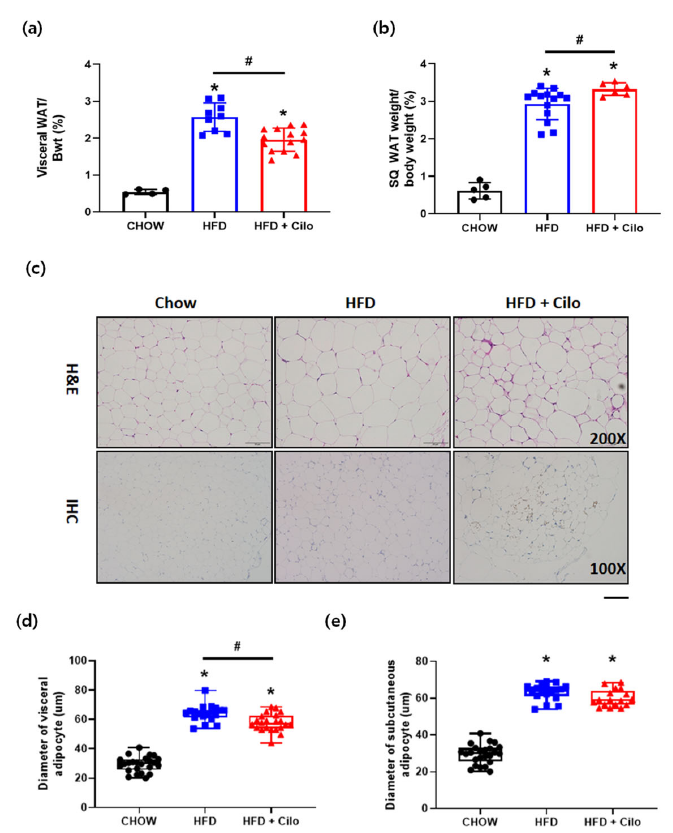
Figure 2. Cilostazol treatment modified WAT and reduced the size of adipocytes in visceral WAT. ( a ) Changes in visceral fat weight; ( b ) changes in subcutaneous fat weight; ( c ) representative histological images of H&E-stained visceral and subcutaneous WAT ( × 200 magnification) of chow control, HFD control, and cilostazol-treated HFD mice; ( d ) diameters of visceral adipocyte tissue from chow control, HFD control, and cilostazol-treated HFD mice; and ( e ) diameters of subcutaneous adipocyte tissue from chow control, HFD control, and cilostazol-treated HFD mice. * p < 0.05 vs. corresponding chow control value and # p < 0.05 vs. corresponding HFD control value. HFD, high-fat diet; Cilo, cilostazol.